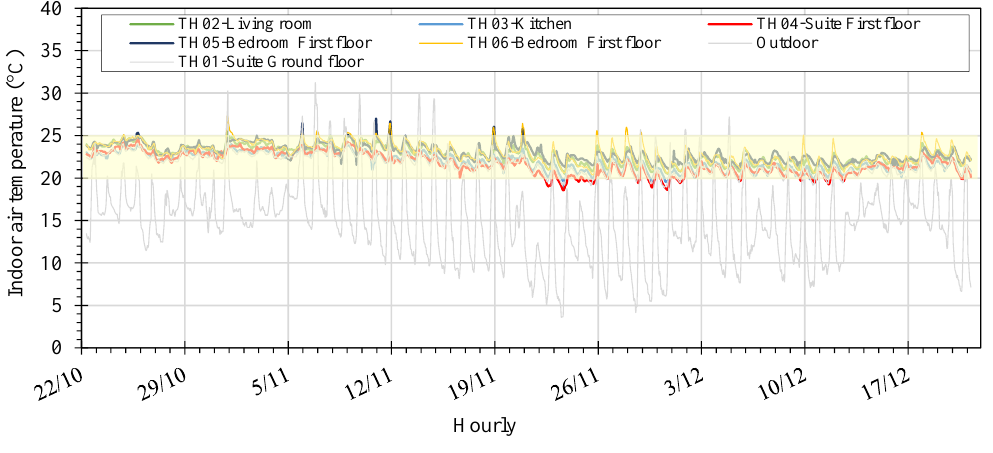
Figure 9. Indoor and outdoor air temperature from monitoring.